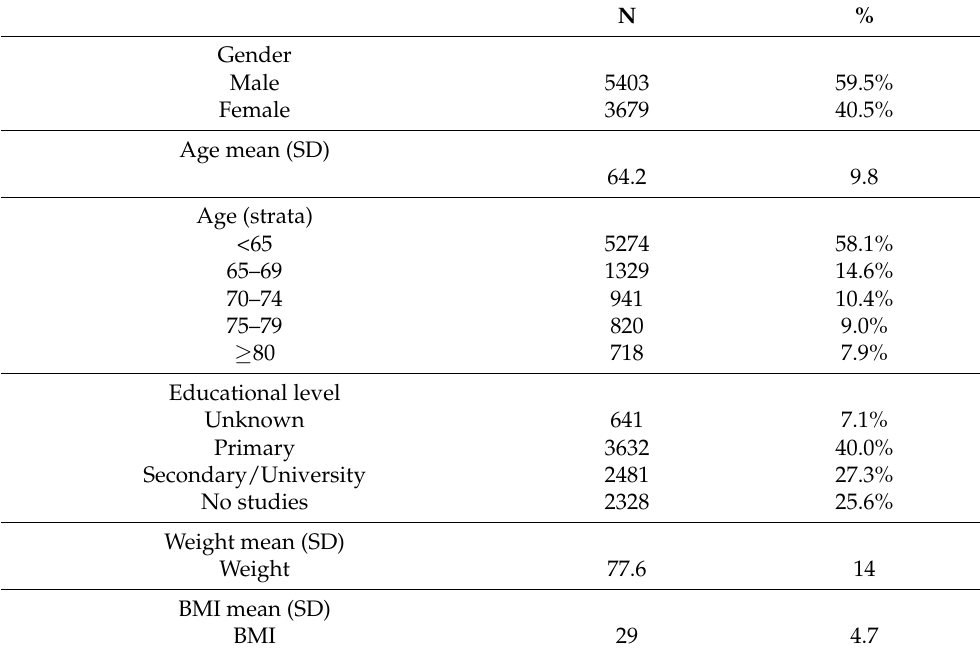
Table 1. Patient Characteristics at Baseline ( n =